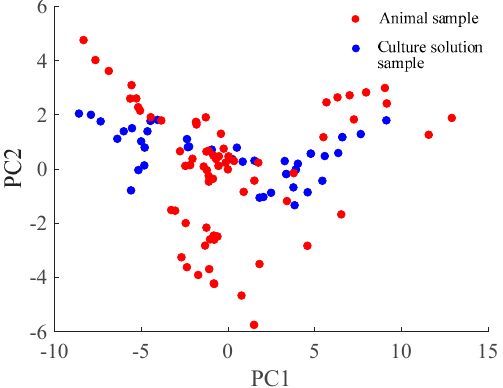
Figure 6. Space distribution of two dataset with different sample carrier.